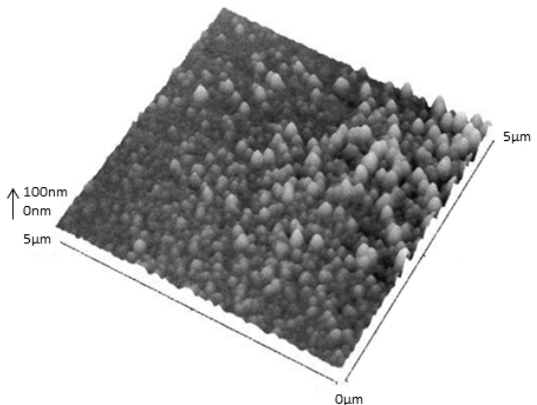
Figure 18. Noncontact mode AFM image of the solid lipid nanoparticles formed by 14 on mica at 5 × 5 µm scan size, z axis is 94 nm. A 20 µL portion of a suspension of the SLNs was deposited, and imaging was performed after drying for 24 h at 25 °C [86].